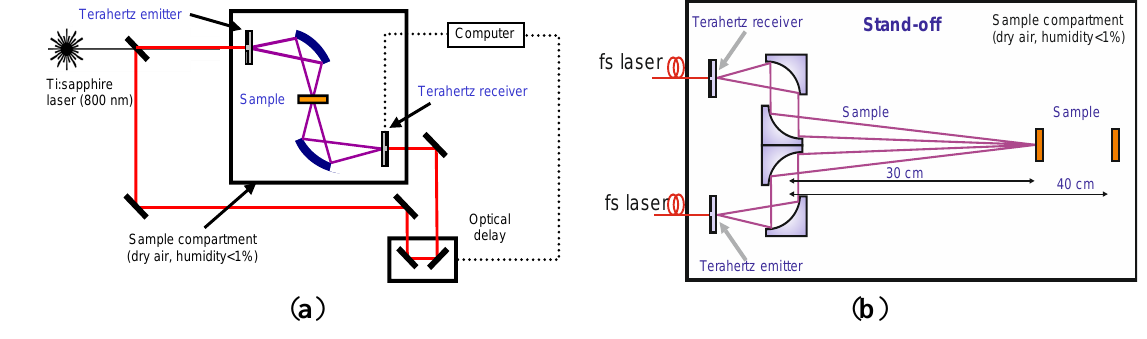
Figure 2. TDS transmission setup ( a ); Reflection stand-off setup ( b ).